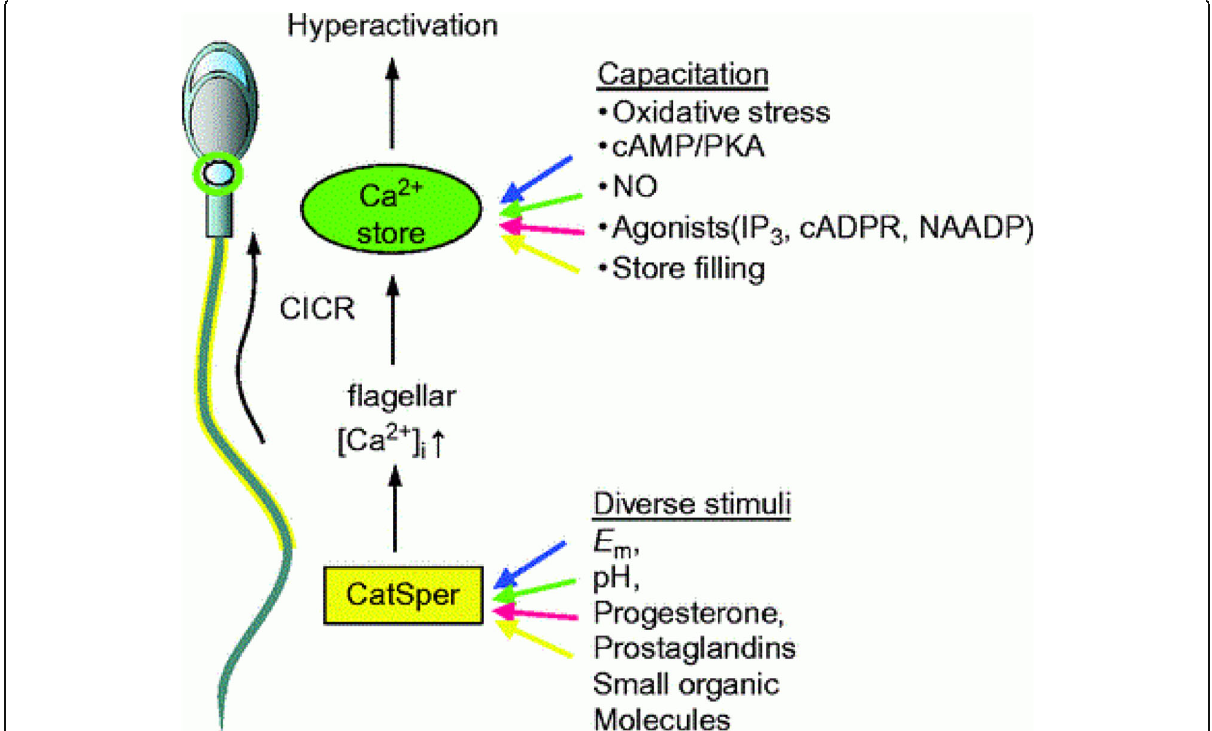
Fig. 3 A diagram showing the role of various stimuli from the female reproductive tract in sperm hyperactivation. Activation of CatSper (Ca 2+ channel) by different stimuli mediates intracellular calcium influx into the flagellum resulting and stimulate flagellar beating thereby enabling penetration into the viscous mucus. Also, there is a subsequent release of stored Ca 2+ at the midpiece region of the spermatozoa